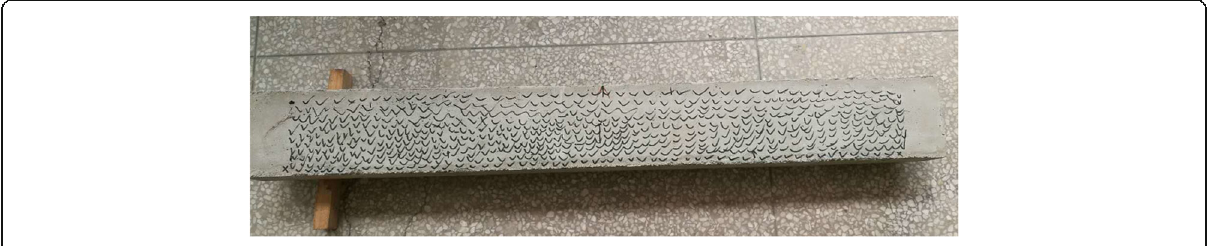
Fig. 6 Beam drawn with dash type targets